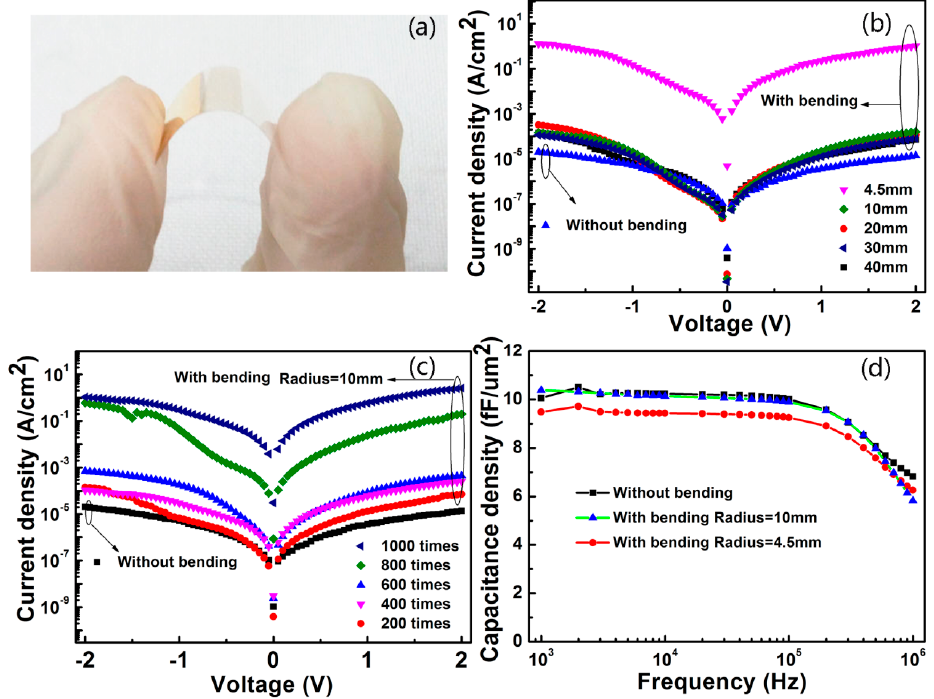
Figure 6. ( a ) The image of the capacitors on PEN; electrical characteristics of the capacitors in bending conditions; ( b ) I-V curves at different bending radii; ( c ) I-V curves with different bending times at a radius of 10 mm; ( d ) C-F curves with and without bending.